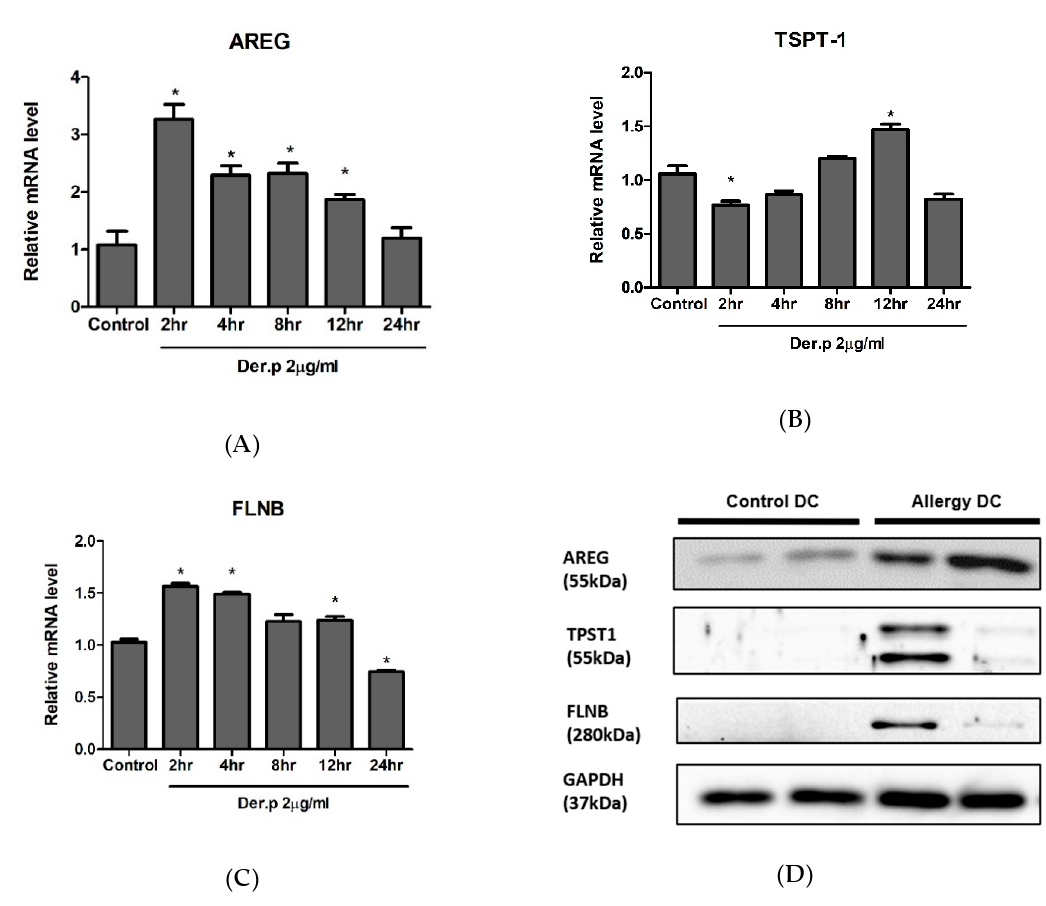
ff erential expressed genes from transcriptome sequencing data. Figure 3. Validation of selected differential expressed genes from transcriptome sequencing data. ( A – Figure 3. Validation of selected di ( A – C ) Quantitative real-time polymerase chain reaction of Der p 1-stimulated THP-1 derived dendritic cells. ( D ) Western blotting of human myeloid dendritic cells sorted from peripheral blood monocytes of healthy controls and patients with allergies. * p <